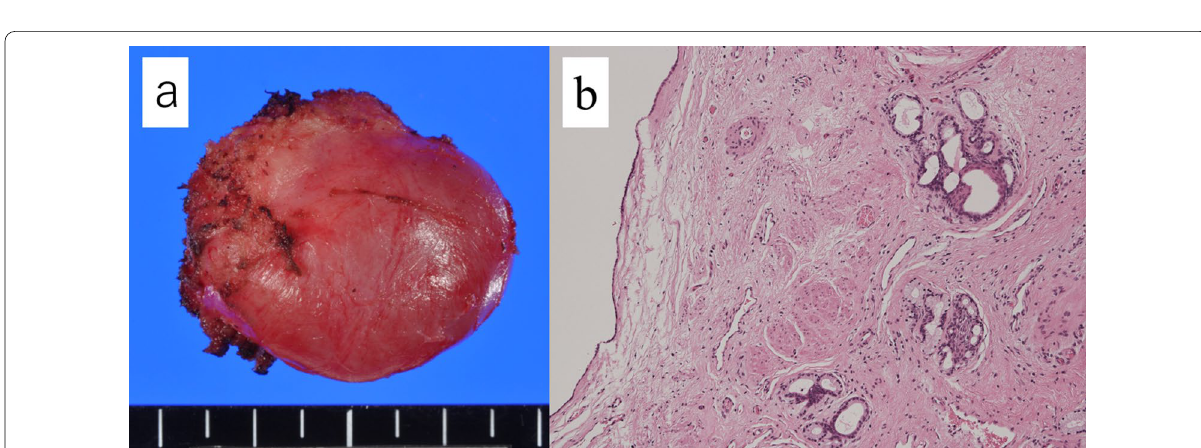
Fig. 5 A multilocular tumor measuring 3 cm in diameter ( a ). The cyst wall was covered with hairline epithelium, stratified squamous epithelium, and columnar epithelium, and the cyst stroma had fibrous tissue, smooth muscle tissue, and peripheral nervous tissue ( b : hematoxylin and